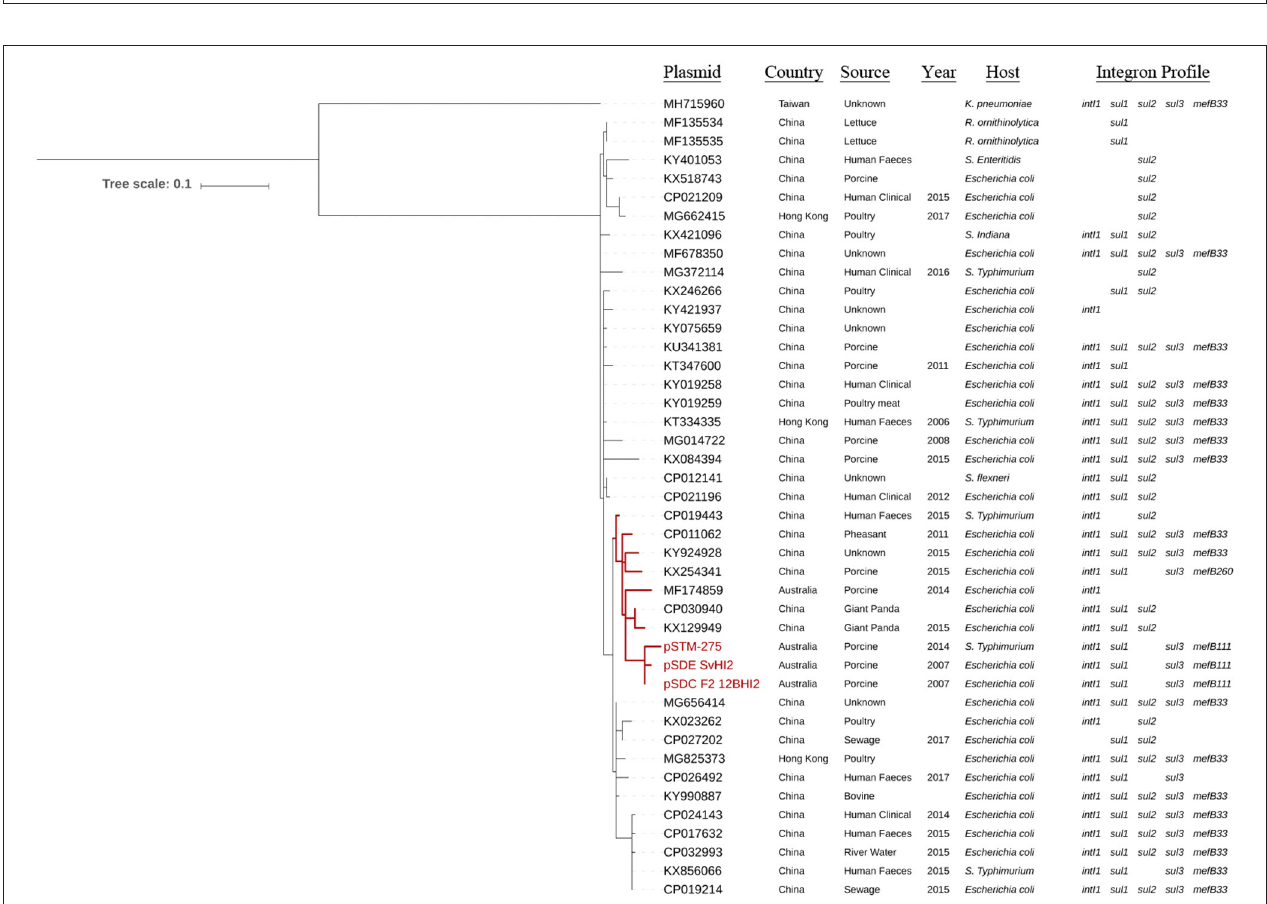
FIGURE 1 | Plasmid maps and alignments of pSDE-SvHI2 (Left) and pSDC-F2_12BHI2 (Right) . Maps display plasmid annotations, with genes color coded by function. Annotations highlight important complex resistance structures and insertions on each plasmid. Inner rings show BLASTn alignments against related IncHI2 ST3 plasmid sequences. Center histograms show GC content.